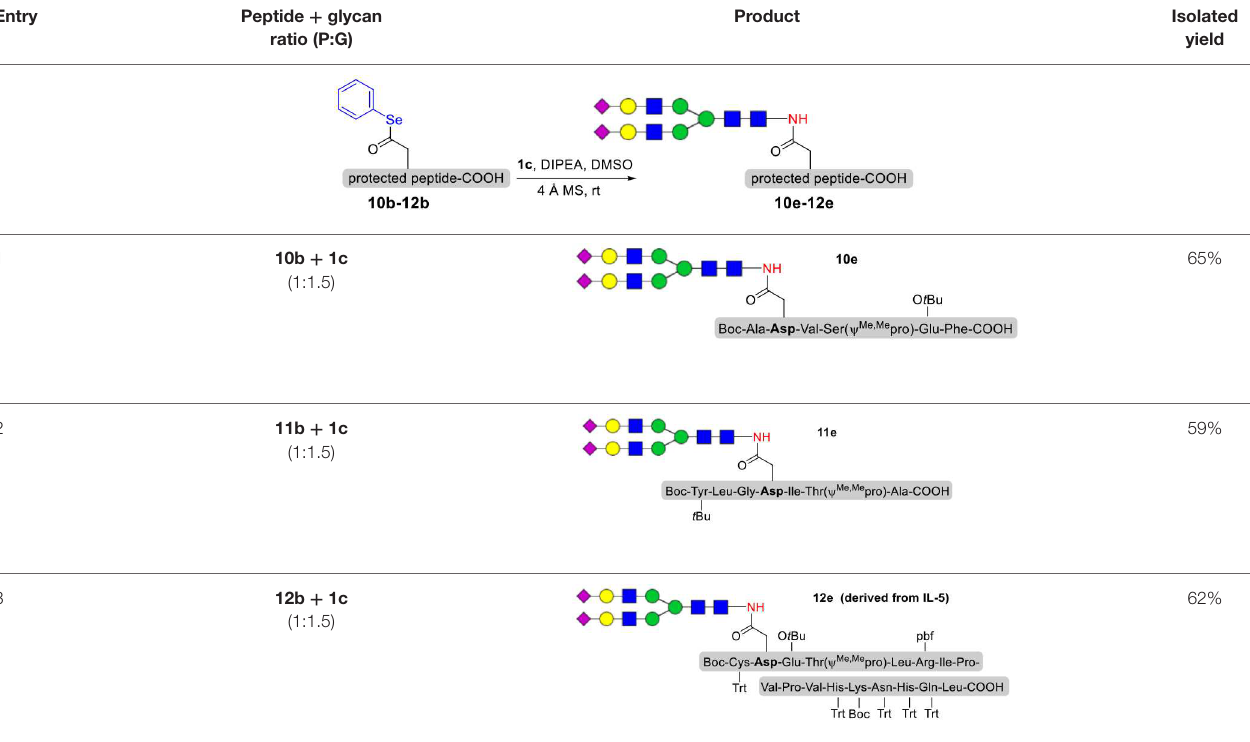
Product Isolated